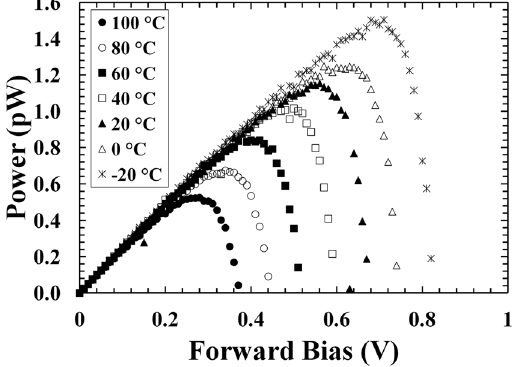
Figure 6. Output power as a function of applied forward bias for the 55 Fe X-ray photovoltaic In 0.5 Ga 0.5 P cell at different temperatures. The temperatures studied were 100 °C (filled circles), 80 °C (empty circles), 60 °C (filled squares), 40 °C (empty squares), 20 °C (filled squares), 0 °C (empty squares), and − 20 °C (stars).